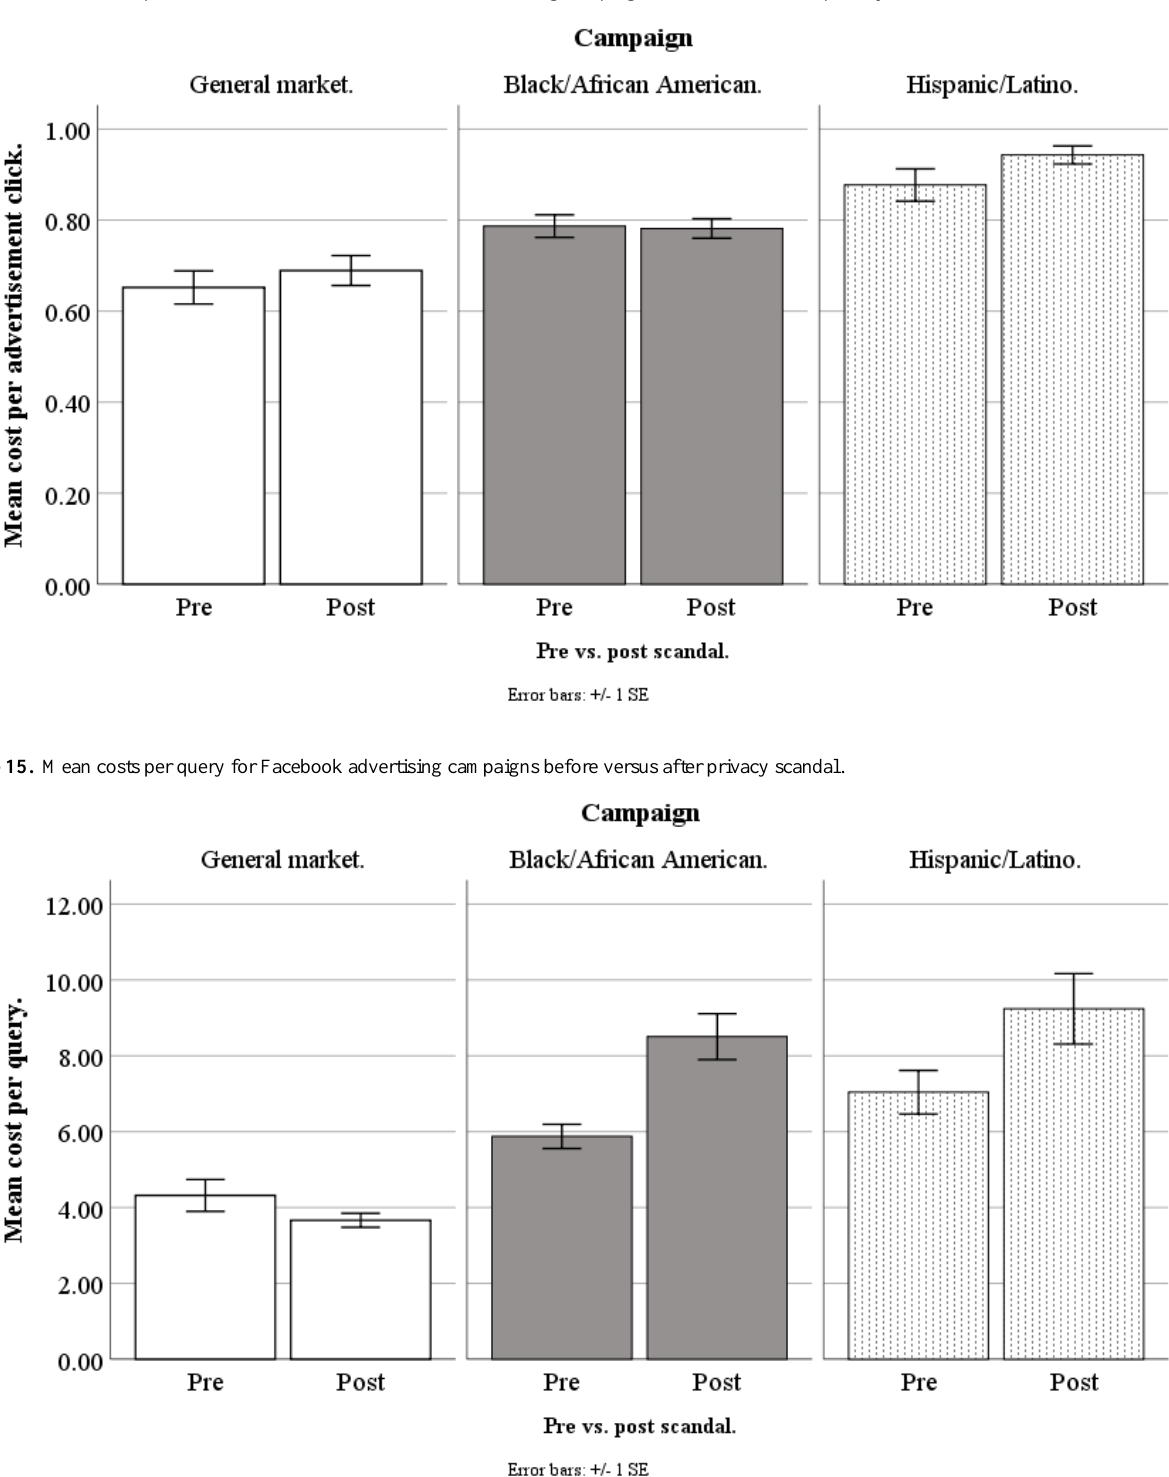
Figure 14. Mean costs per advertisement click for Facebook advertising campaigns before versus after privacy scandal.